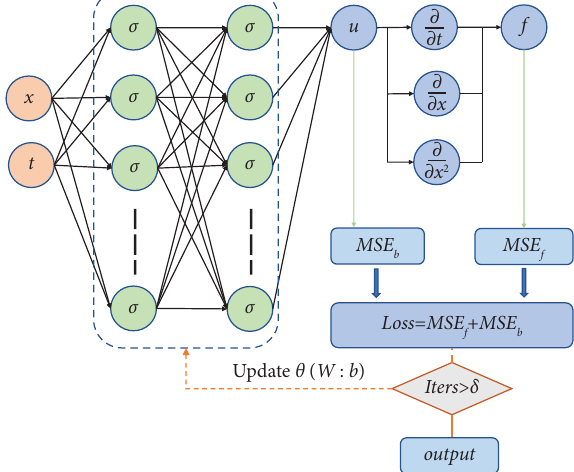
Figure 2: Schematic diagram of a